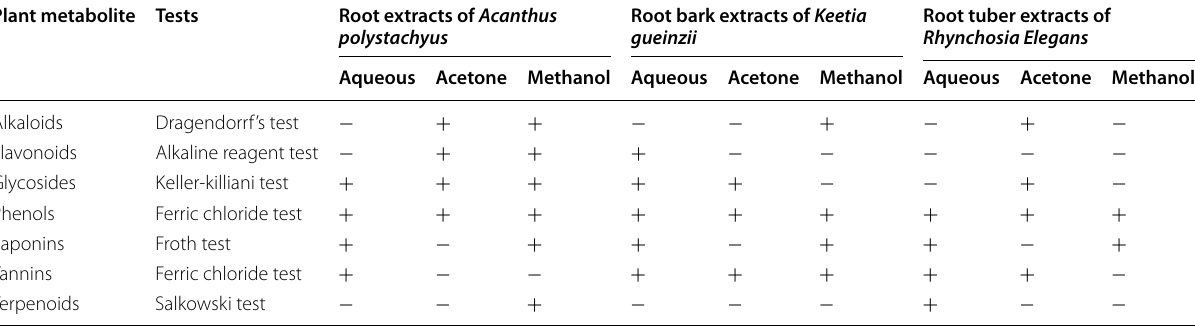
Table 2 Preliminary phytochemical screening of crude root, root bark, and root tuber extracts of Acanthus polystachyus , Keetia gueinzii , and Rhynchosia elegans